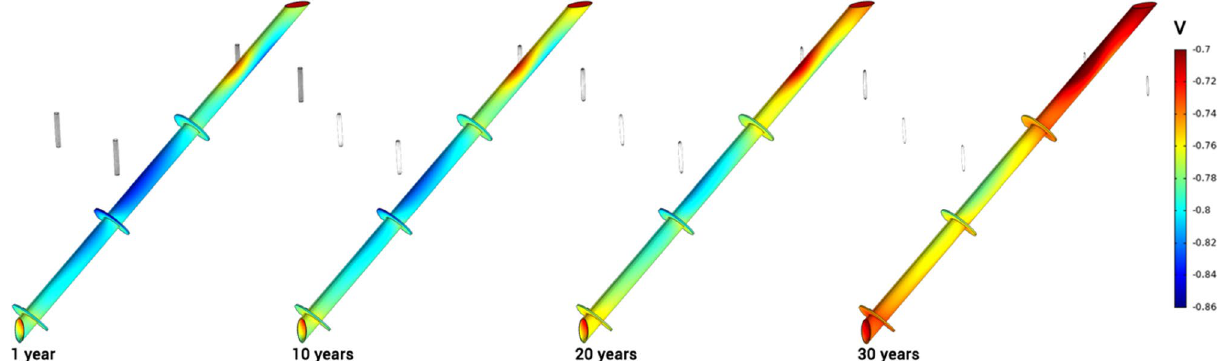
Figure 9. Variation of potential (V-CSE) distribution on the pile is shown for different years after CP system commissioning.